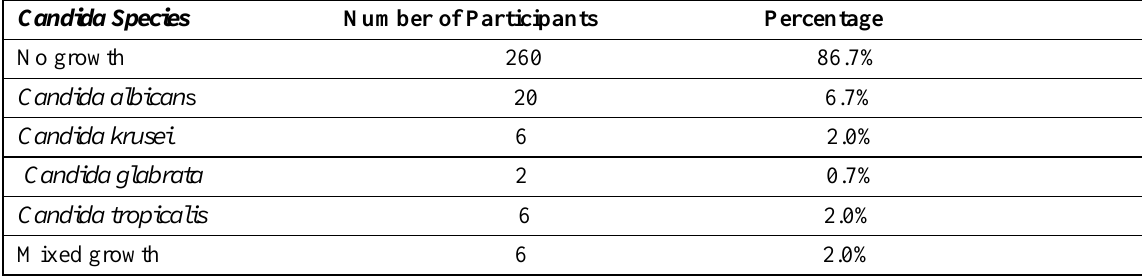
Table 2. Prevalence of oral candidiasis in HIV/AIDS patients.